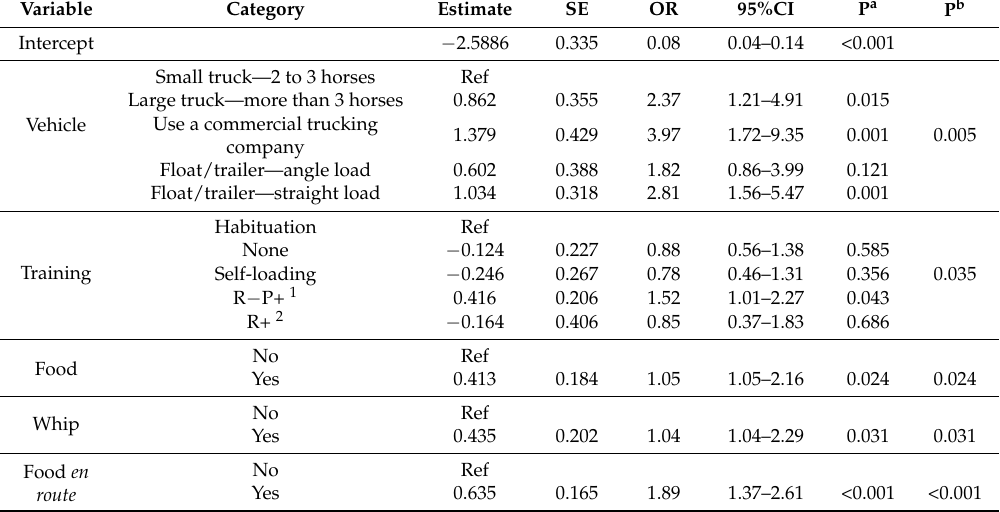
Table 5. Results of multivariable regression analysis of associations between TRPBs and the explanatory variables, experience, industry sector, and type of involvement (amateur/professional). Data were collected from an online survey on horse road transport in New Zealand ( n = 1124) for movements occurring between 2015 and 2017 (SE: standard error; OR: odds ratio; CI: confidence intervals; P a : LRT P value; P b : Wald test P